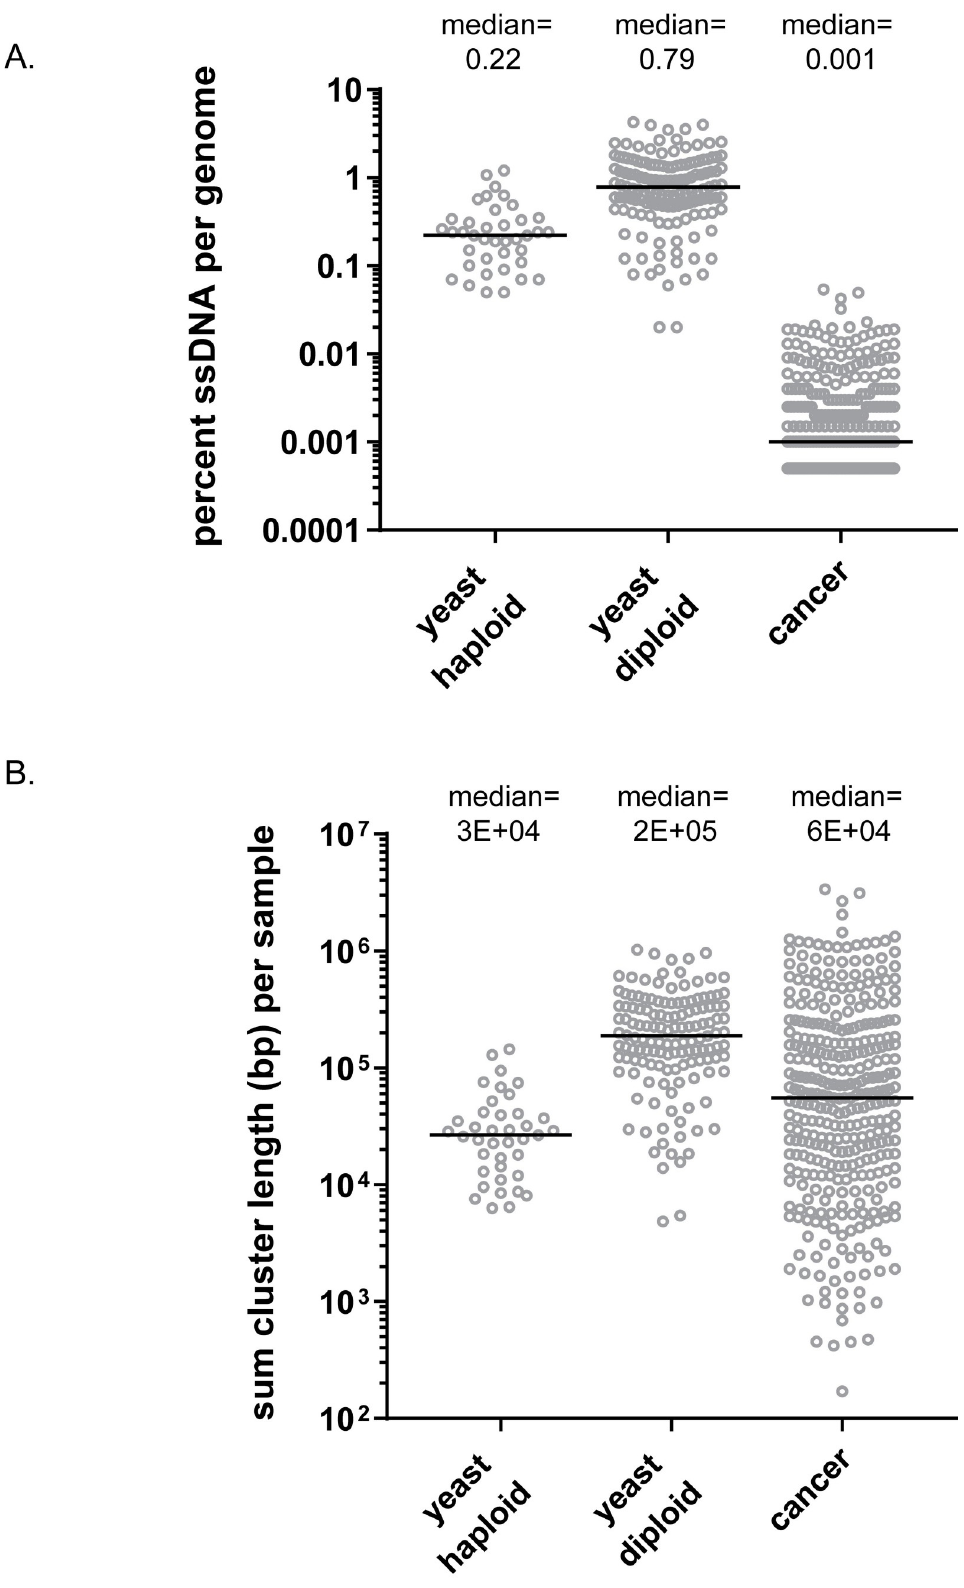
Fig 3. Estimates of the hypermutable ssDNA per genome. (A) The percentages of ssDNA per genome in WT yeast haploid and diploid Can1-Red colonies and APOBEC-enriched human cancer types, including Bladder-TCC, Breast-